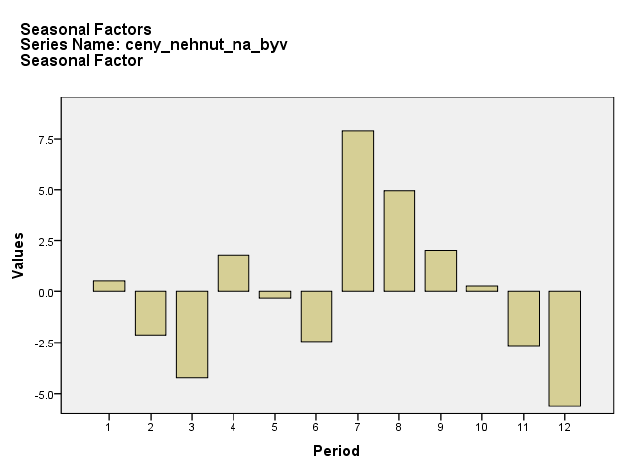
Figure 5. Seasonality of real estate prices.